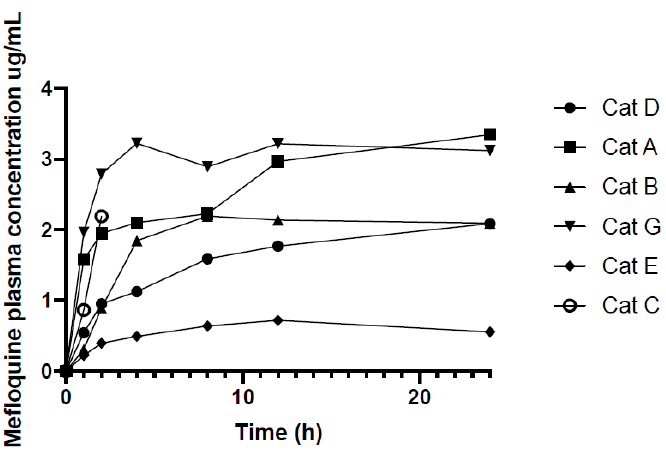
Figure 1. Mefloquine plasma concentrations (ug/mL) of seven cats over 336 h (14 days after initial dose). Cats were medicated with 62.5 mg per cat (10–12 mg/kg) after t = 0, 96, 168 and 240 h. Blood was taken just prior to treatment as denoted by vertical dotted lines.